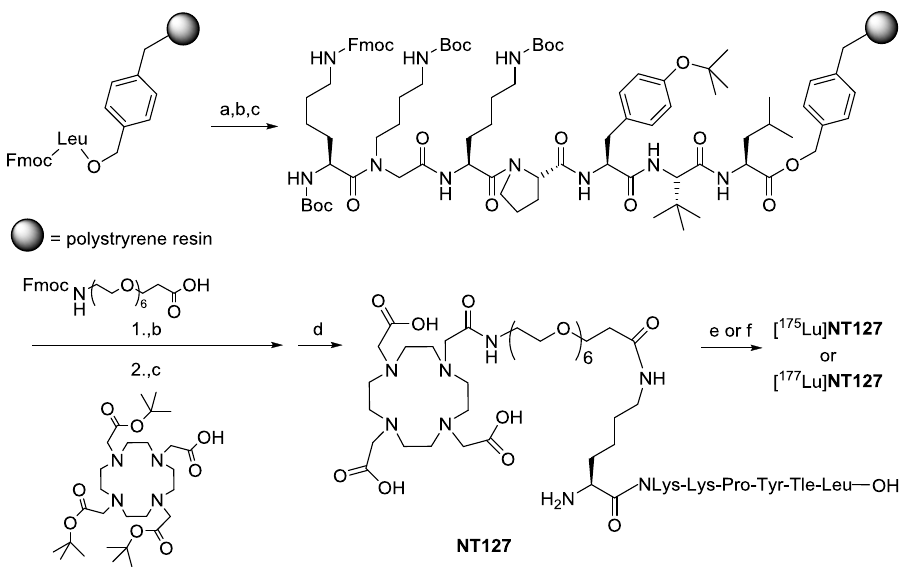
coupling for Fmoc-Tle-OH, Fmoc-Tyr( t Bu)-OH, Fmoc-Pro-OH, Fmoc-21-amino-4,7,10,13,16,19-hexaoxaheneicosanoic acid: Fmoc-AA-OH, PyBOP, DIPEA, HOBt, DMF, μ~, Fmoc-AA-OH, HATU, coupling deprotection/cleavage of the peptide: (1) H SO /dioxane (1:9), 8 °C, 2 h; (2) DIPEA/CH 2 4 phenol, H O, triisopropylsilane 88:5:5:2, 2 h, followed by RP-HPLC; ( e ) Lu(NO 2